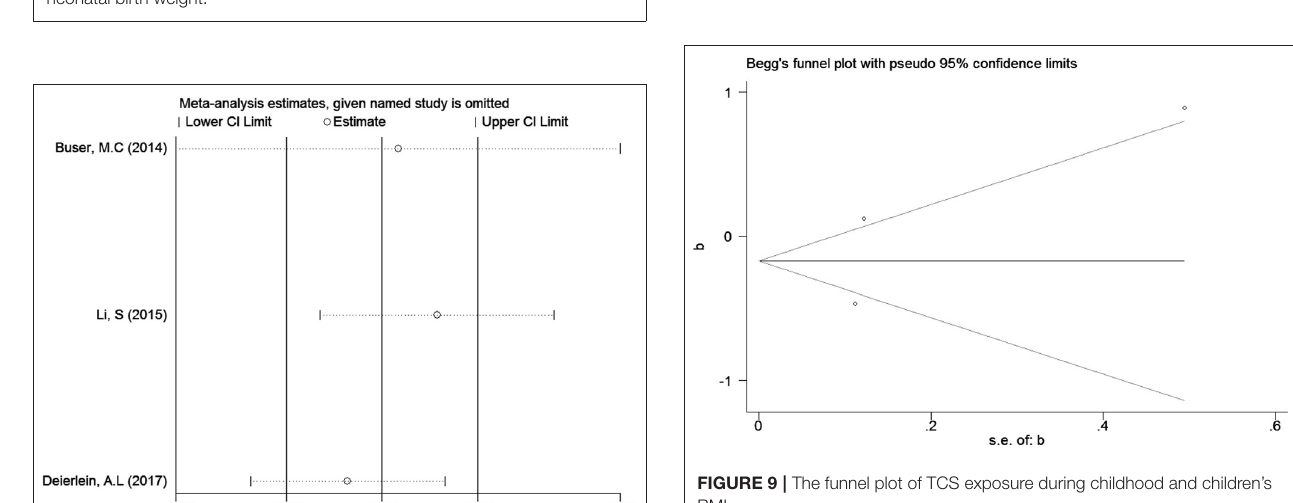
FIGURE 6 | Sensitivity analysis of TCS exposure during pregnancy and neonatal birth weight.